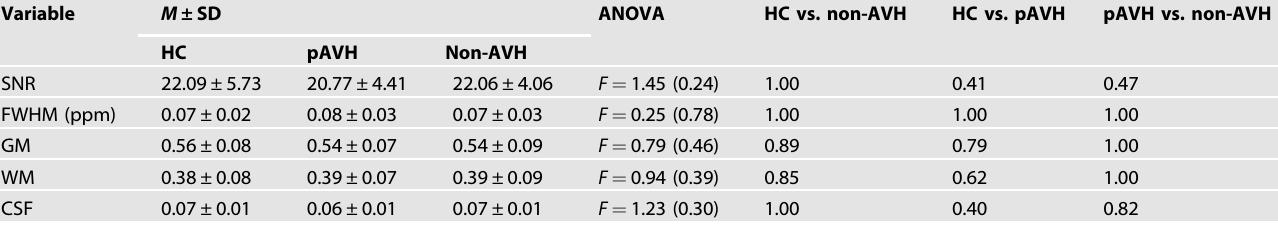
Table 2. Quality of MRS data of patients and healthy controls. Variable